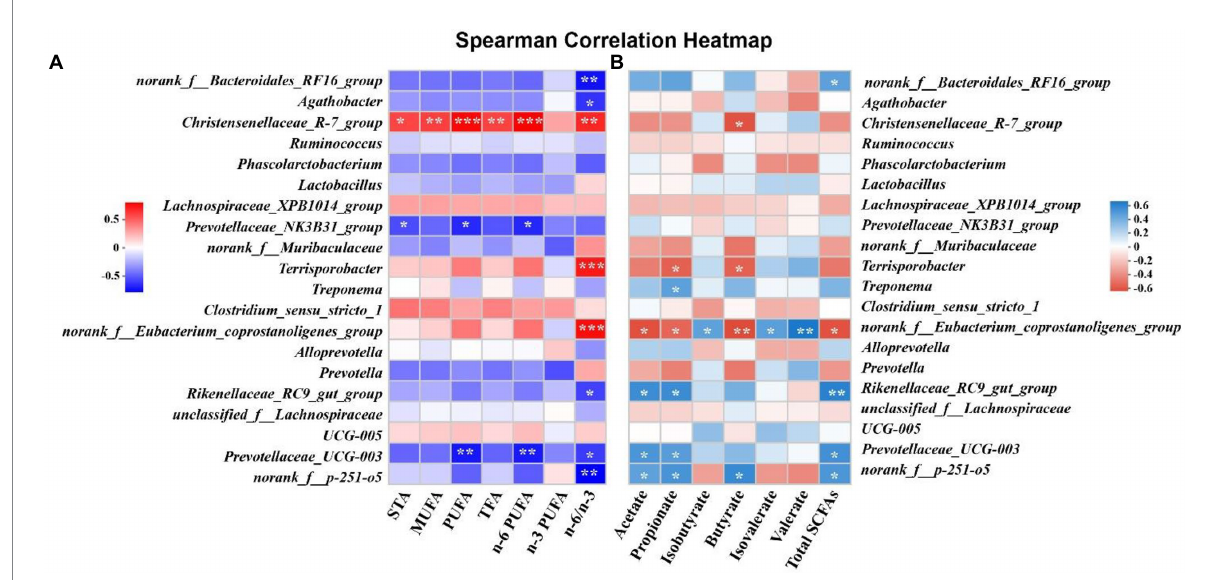
FIGURE 6 The correlation matrix of cecal genera, free fatty acids and short-chain fatty acids (SCFAs). (A) The correlation between cecal genera and free fatty acids in semitendinosus muscle. (B) The correlation between cecal genera and SCFAs in cecal chyme. *, ** and *** indicates p <0.05, p <0.01 and p <0.001, respectively. STA, saturated fatty acid; MUFA, monounsaturated fatty acid; PUFA, polyunsaturated fatty acid; TFA, total fatty